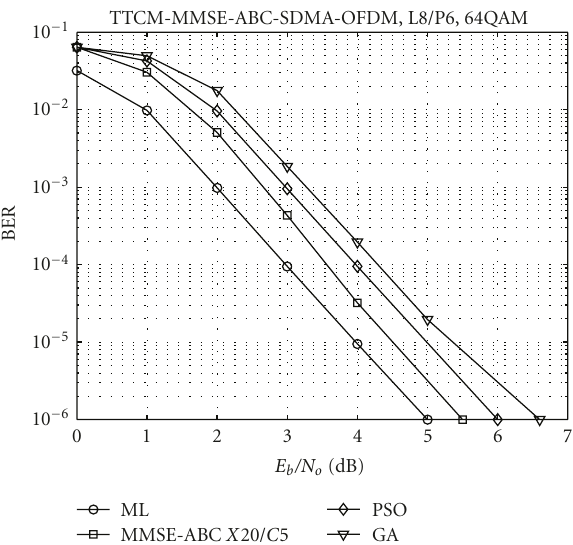
Figure 4: BER versus E b /N o performance comparison of 8 × 6 system for 4-QAM demodulator.